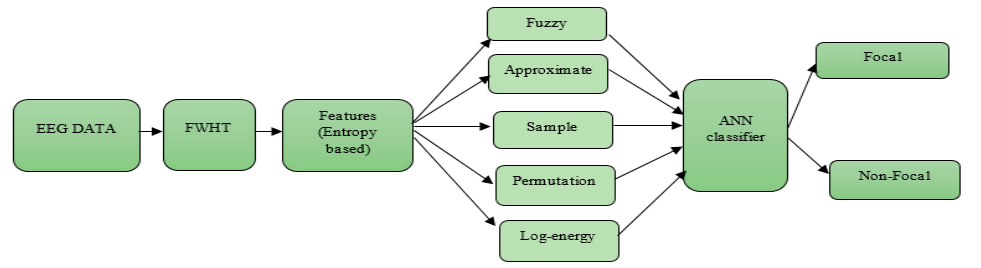
Figure 4. Block diagram of the proposed work.